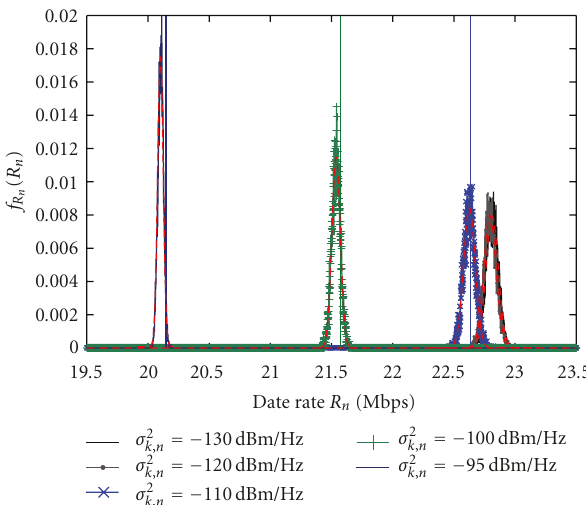
Figure 5: The PDF f R ( R n ) for a transmission line n = 1, and for n di ff erent background noise levels, are depicted by the dashed red lines. The curves following the figure legend are the corresponding Monte Carlo simulations. The data rates calculated with (3), are represented by the vertical lines.